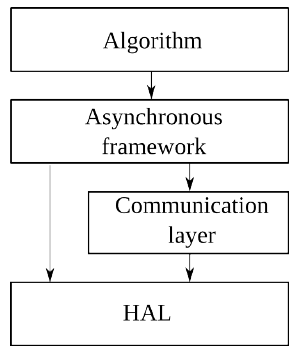
Figure 8: Simplified data flow diagram of the simulation environ- ment.